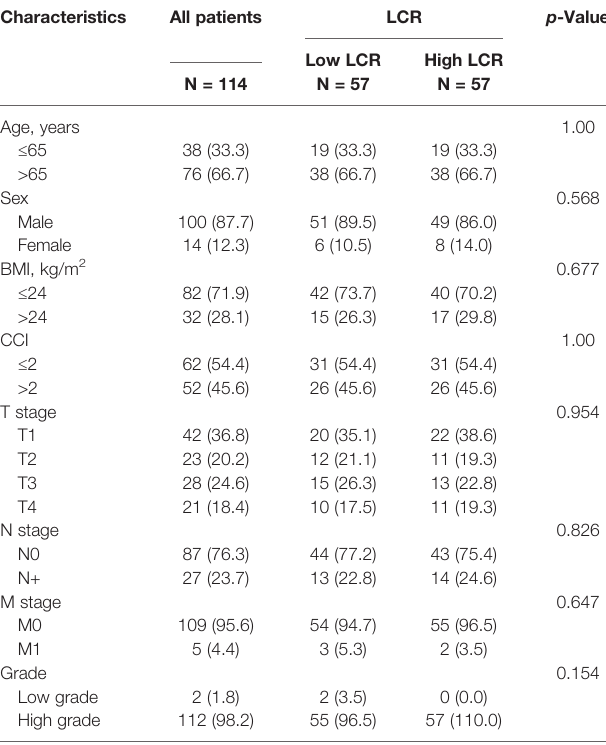
TABLE 4 | Clinical characteristics of the patients according to LCR after PSM.